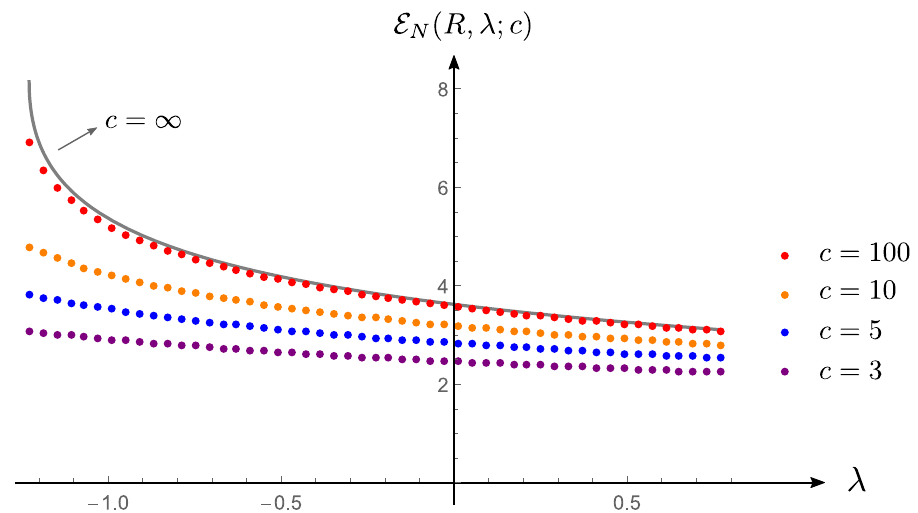
( R , λ , c ) for finite c . We take N = 10, R = 30 and plot Figure 4: Deformed energy E N = − 1.22814 to λ + 2 for c = 3,5,10,100. The gray continuous the energy from λ c c line is the deformed energy at c = ∞ , which is given by the analytical result. We see the deformed energy decreases while decreasing the value of c .